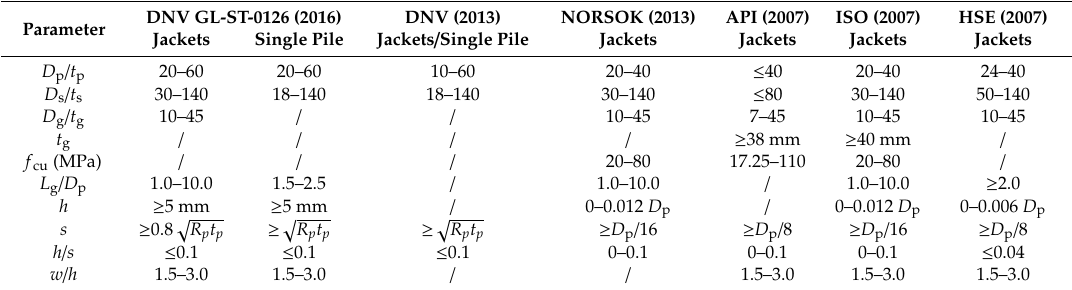
Table 1. Geometric and material parameters in di ff erent codes. DNV-GL, Det Norske